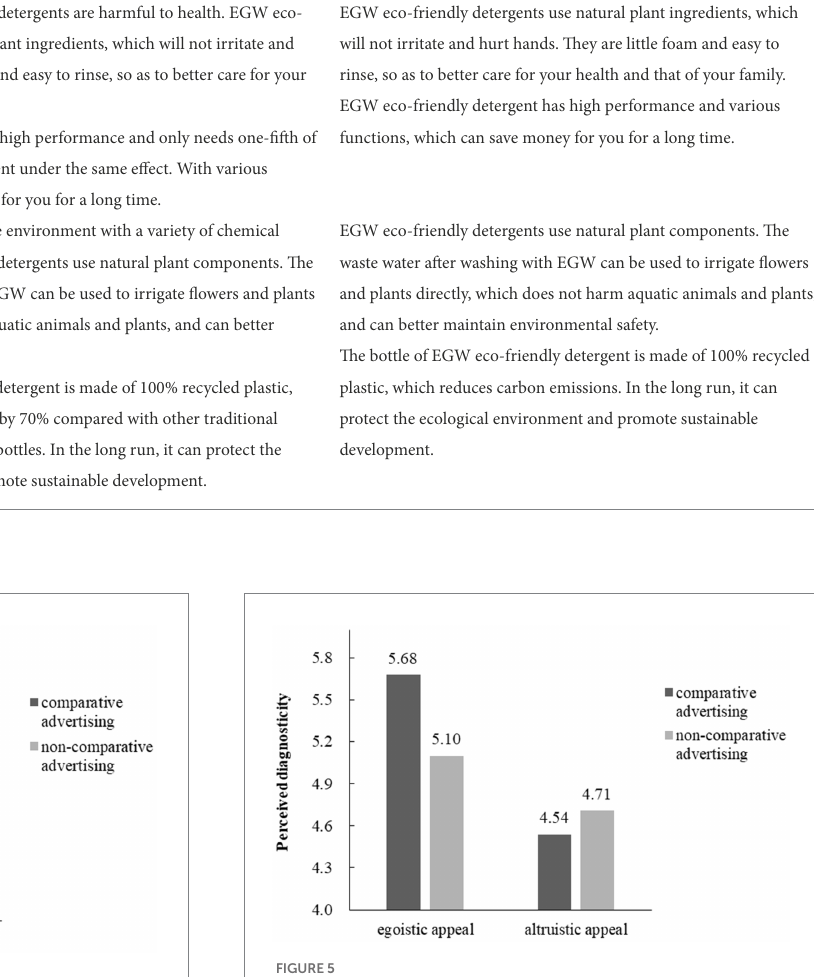
FIGURE 4 The interaction effect between advertising types and advertising appeals on